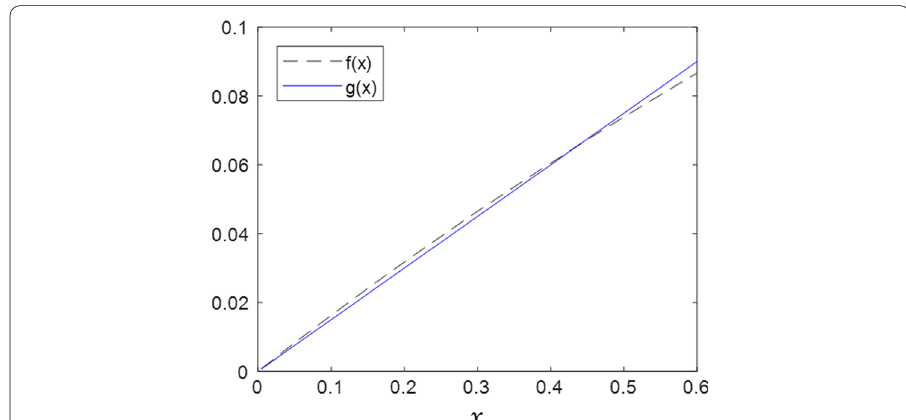
Fig. 4 Comparison of original function, f ( x ), and linear approximation, g ( x ). Functions show excellent agreement over a realistic range of x